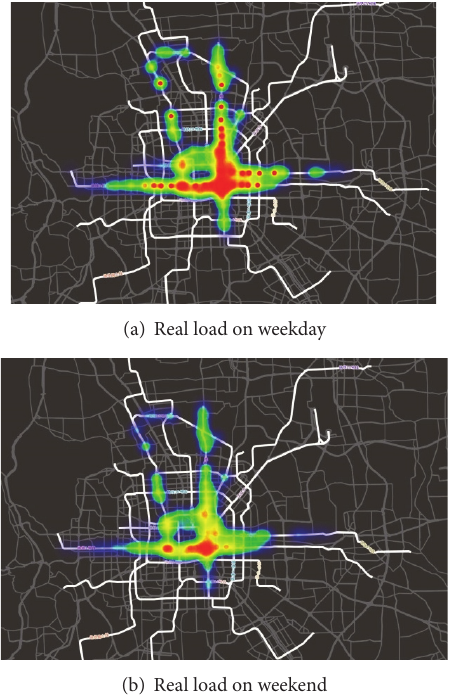
Figure 8: Real load spatial patterns on weekday and